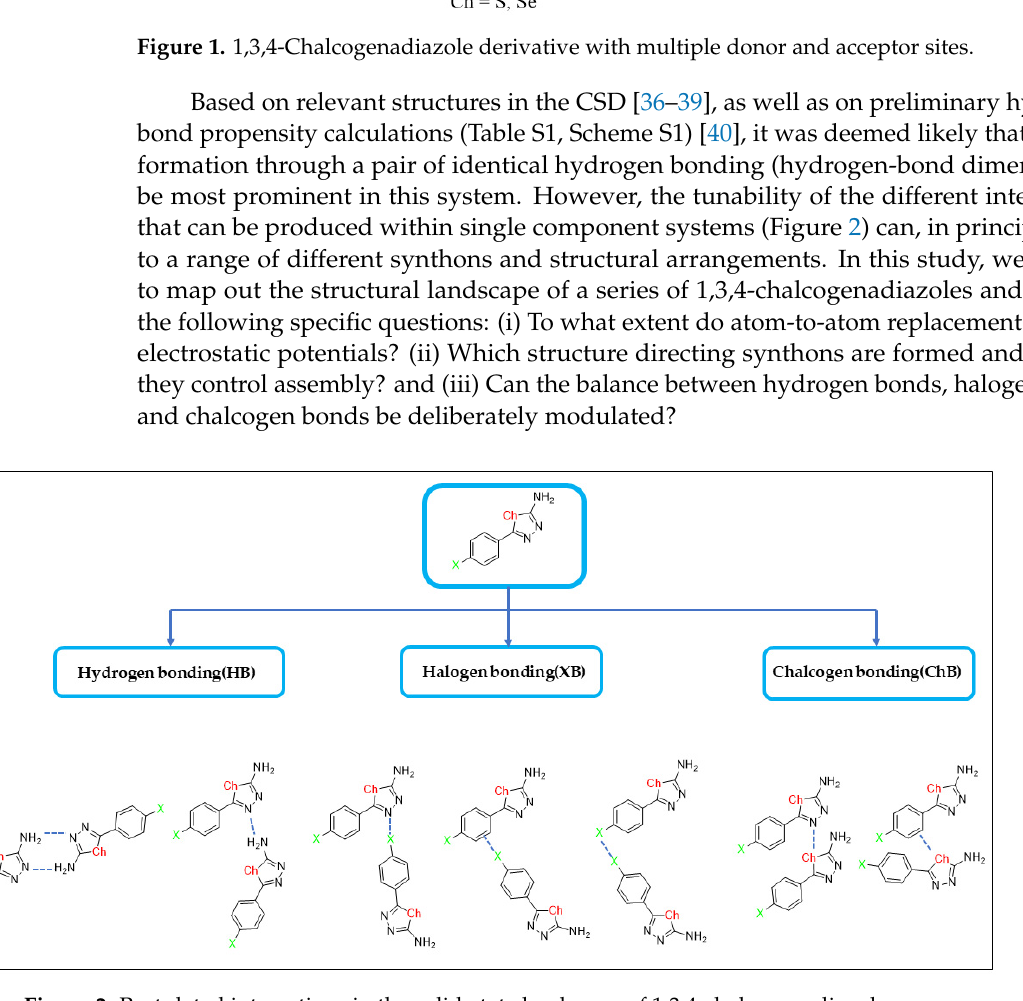
Figure 2. Postulated interactions in the solid-state landscape of 1,3,4-chalcogenadiazoles.